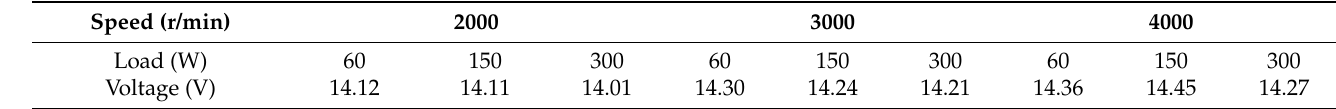
Table 1. Simulation calculation results of the output